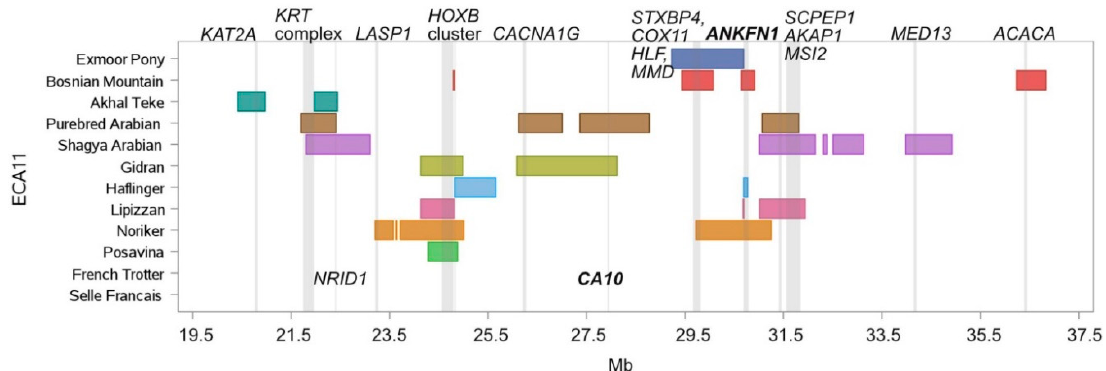
Figure 3. ROH islands on ECA11 between 19.5 Mb and 37.5 Mb. Location and length of ROH islands (shared by more than 50% of individuals per breed) per breed are illustrated as horizontal boxes, location of genes of specific interest are indicated as vertical lines.